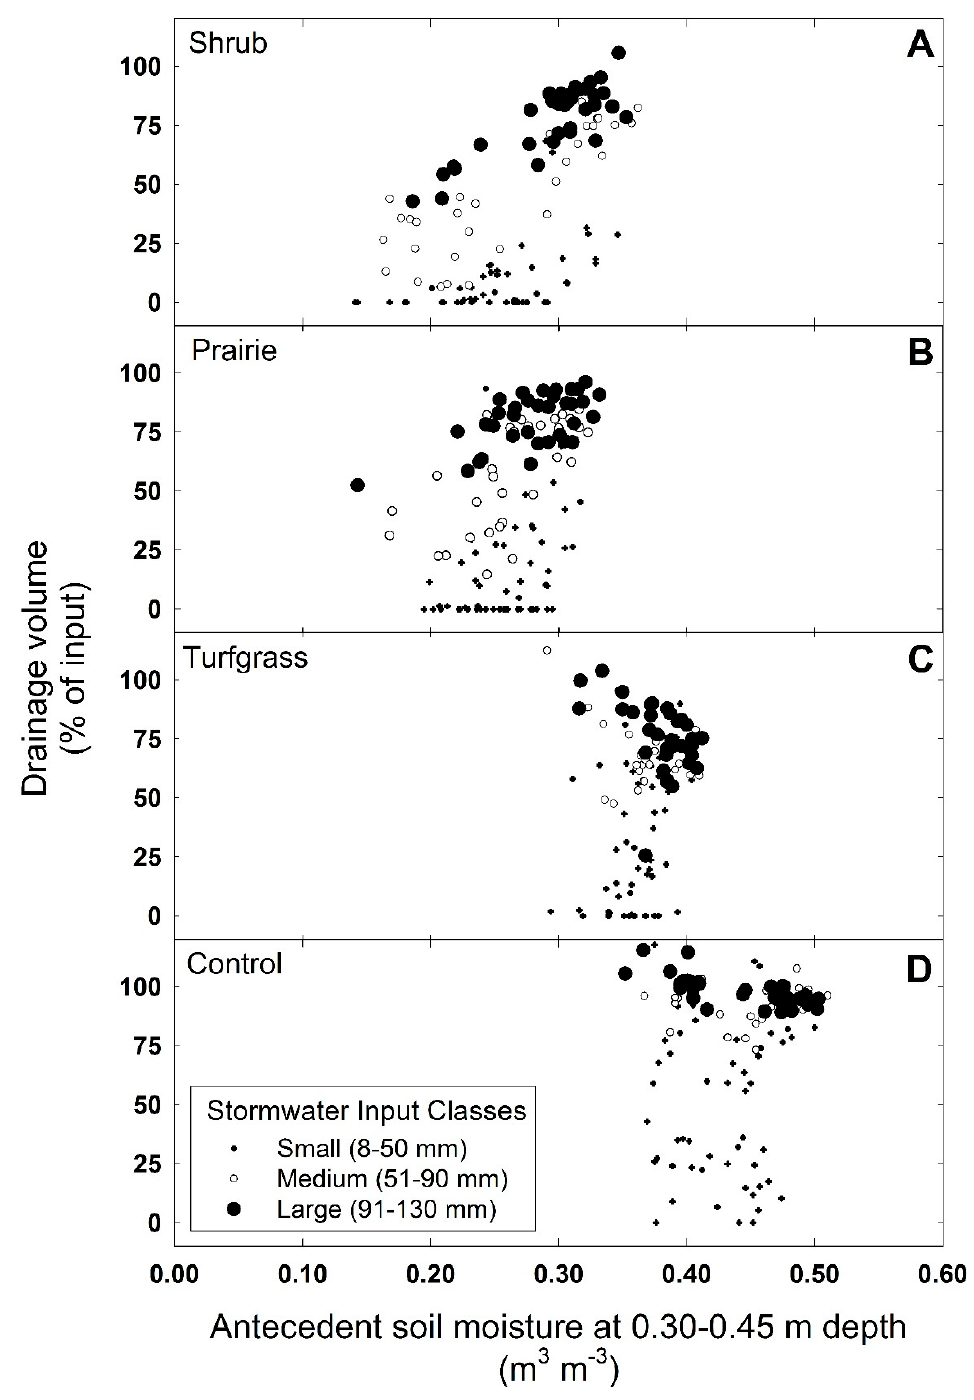
Figure 5. Shift in antecedent soil moisture at a depth of 0.30–0.45 and effect on drainage volume (% of input) by vegetative treatment: ( A ) shrub, ( B ) prairie, ( C ) turfgrass, and ( D ) control (no vegetation). Input data were separated into three classes by size: small inputs (8–50 mm), medium inputs (51–90 mm), and large inputs (91–130 mm). Plotted values are raw data for individual mesocosms in response to 41 stormwater events.